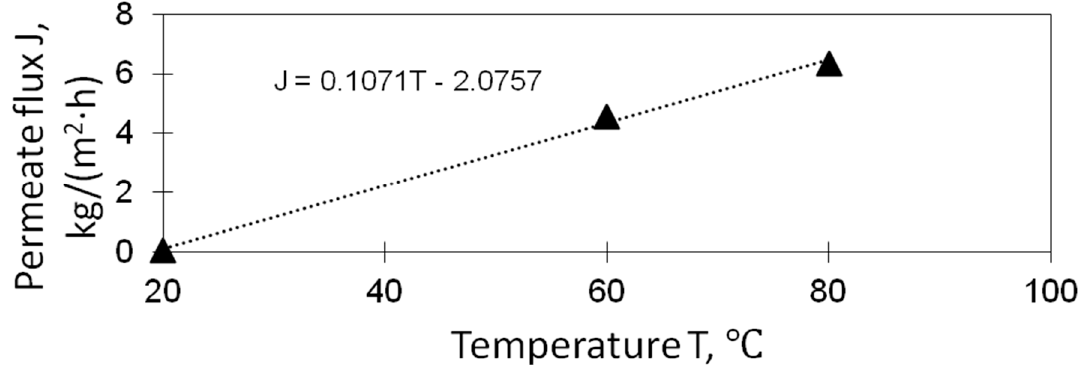
Figure 5. Experimental data of AGMD-MC module performance as a function of feed temperature.